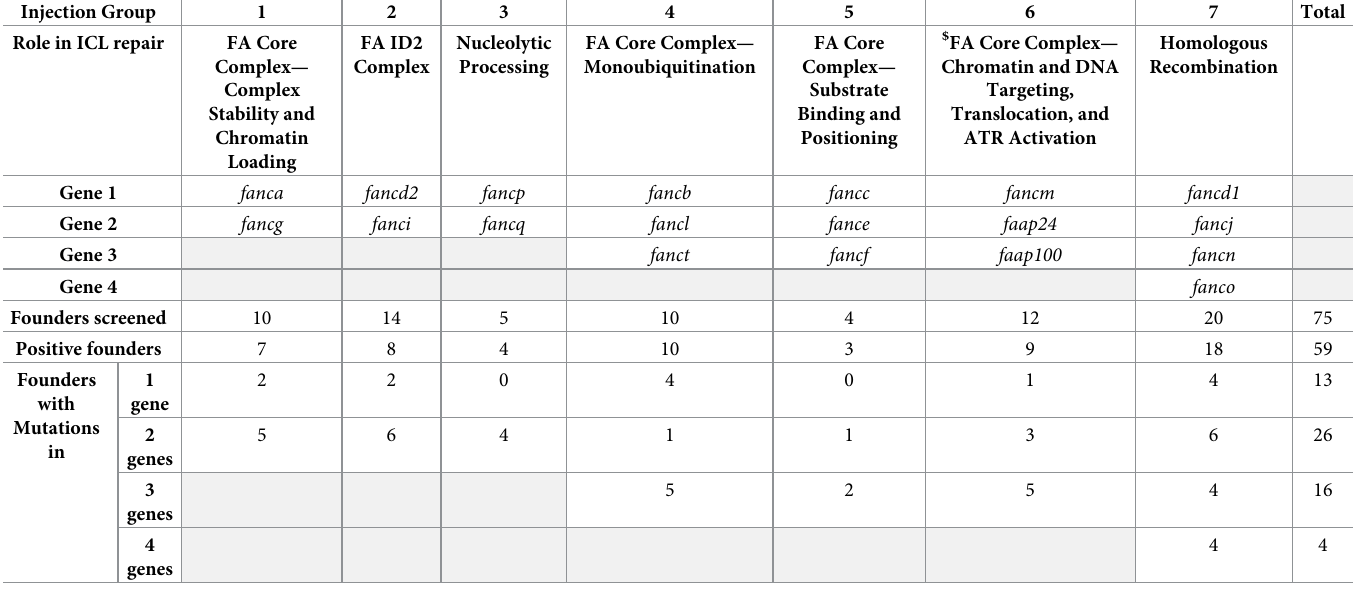
Table 1. Multiplexing scheme and efficiency of germline transmission of mutations in co-targeted